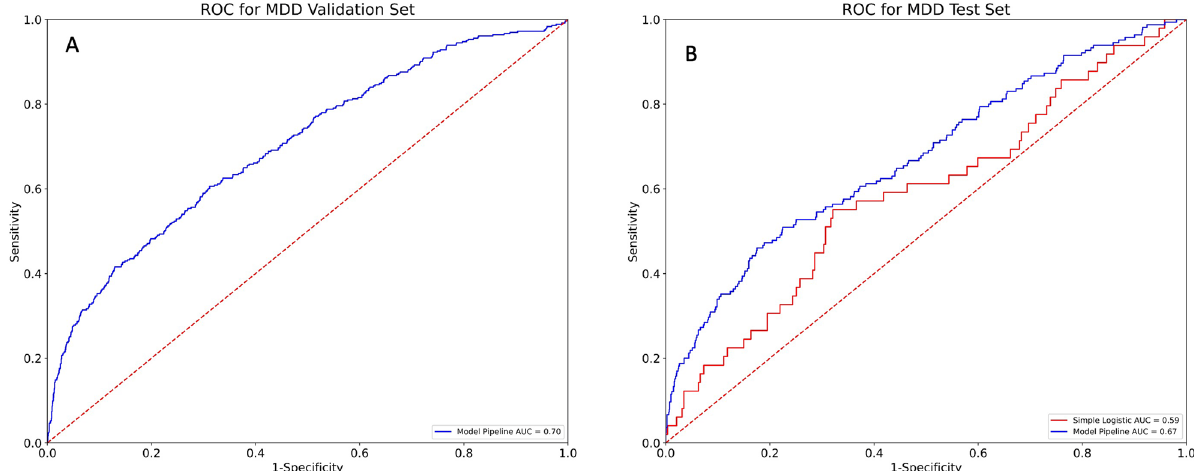
Figure 2. ( A ) AUC for prediction of MDD in the training set. ( B ) AUC for the prediction of depression in the held-out test set using both a simple logistic regression and our novel pipeline. These curves show the sensitivity and specificity at different thresholds for